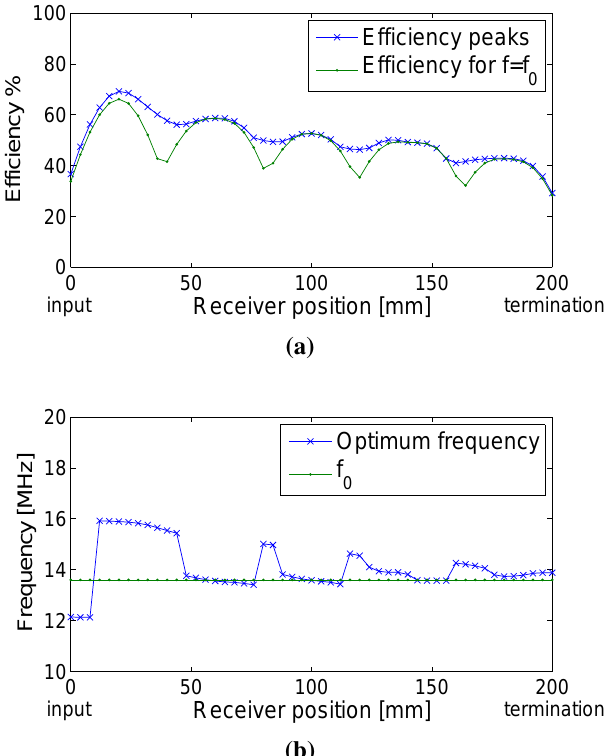
Figure 11. Comparison between simulated envelopes of efficiency and efficiency peaks ( a ) and optimum frequencies ( b